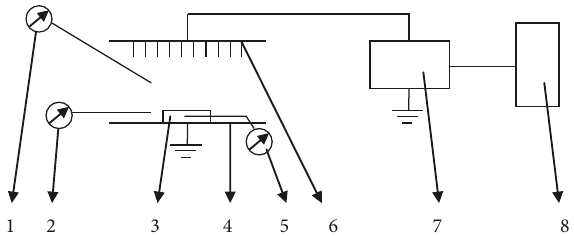
Figure 1: Schematic diagram of high-voltage electric field thawing equipment. (1) Thermometer; (2) hygrometer; (3) frozen beef; (4) ground electrode; (5) temperature sensor; (6) needle electrode; (7) high-voltage power source; (8) voltage